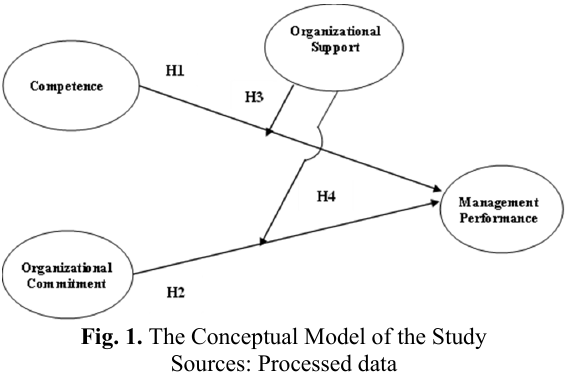
Fig. 1. The Conceptual Model of the Study Sources: Processed